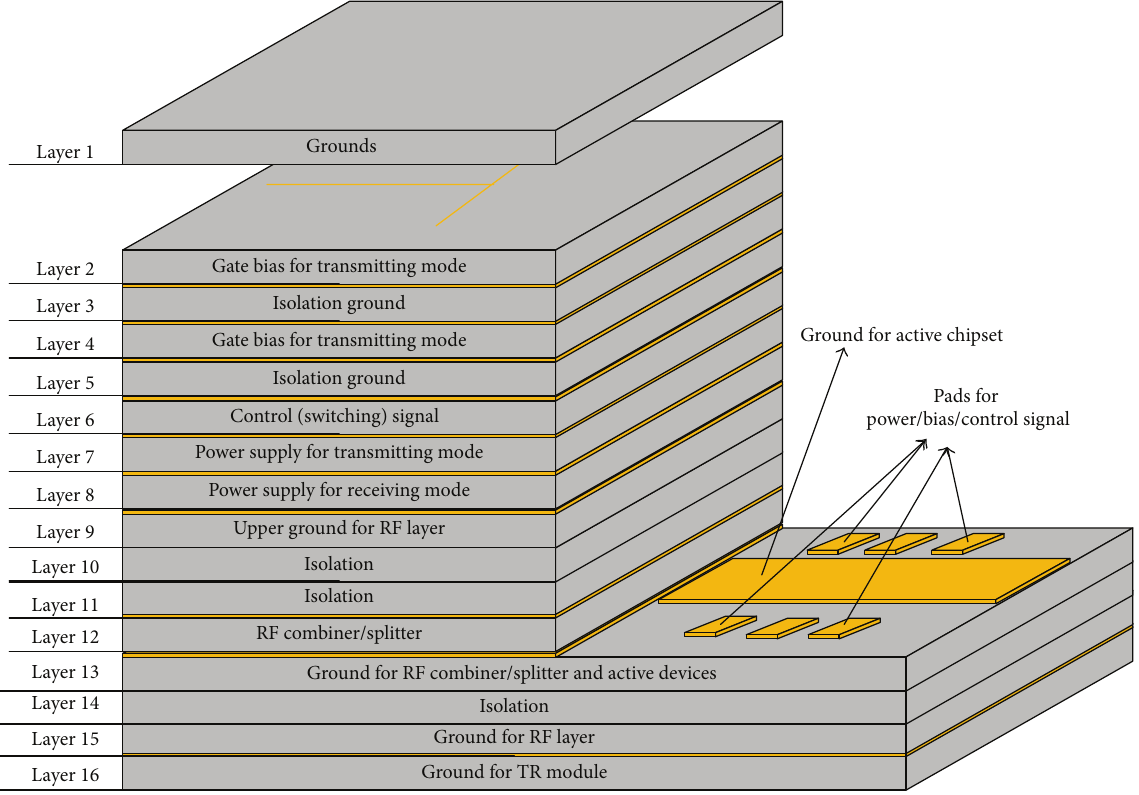
Figure 2: The housing cavity of the MFPA.